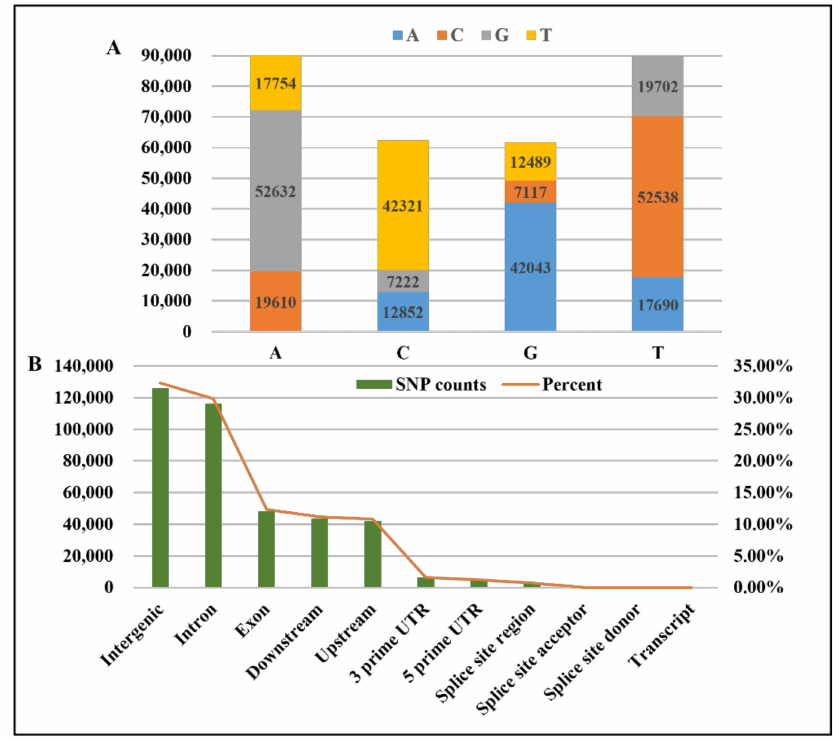
Figure 2. The DNA base mutation and location in the genome of differential SNPs. ( A ) DNA base mutation of differential SNPs; ( B ) location in the genome of differential